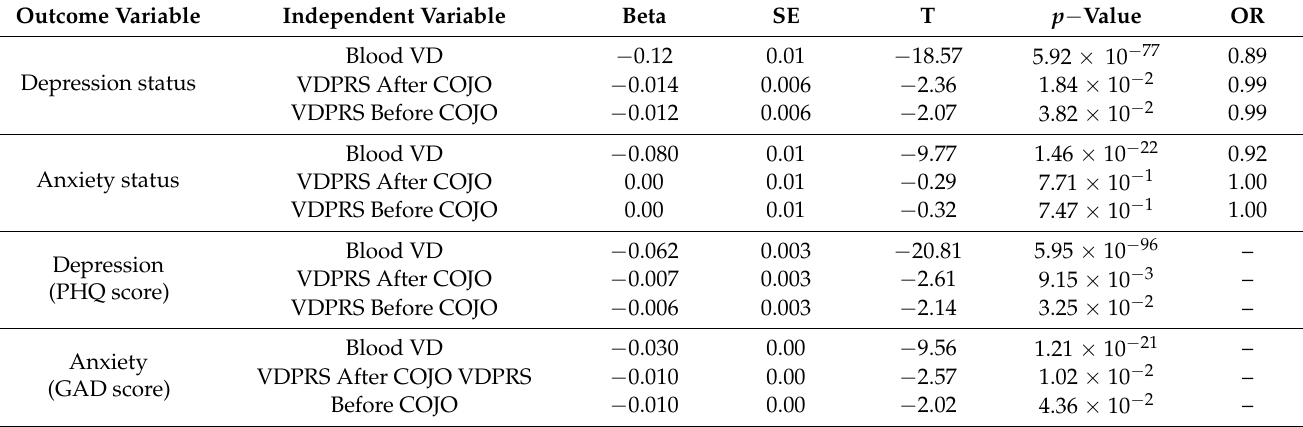
Table 2. The associations between Vitamin D traits and traits of depression and